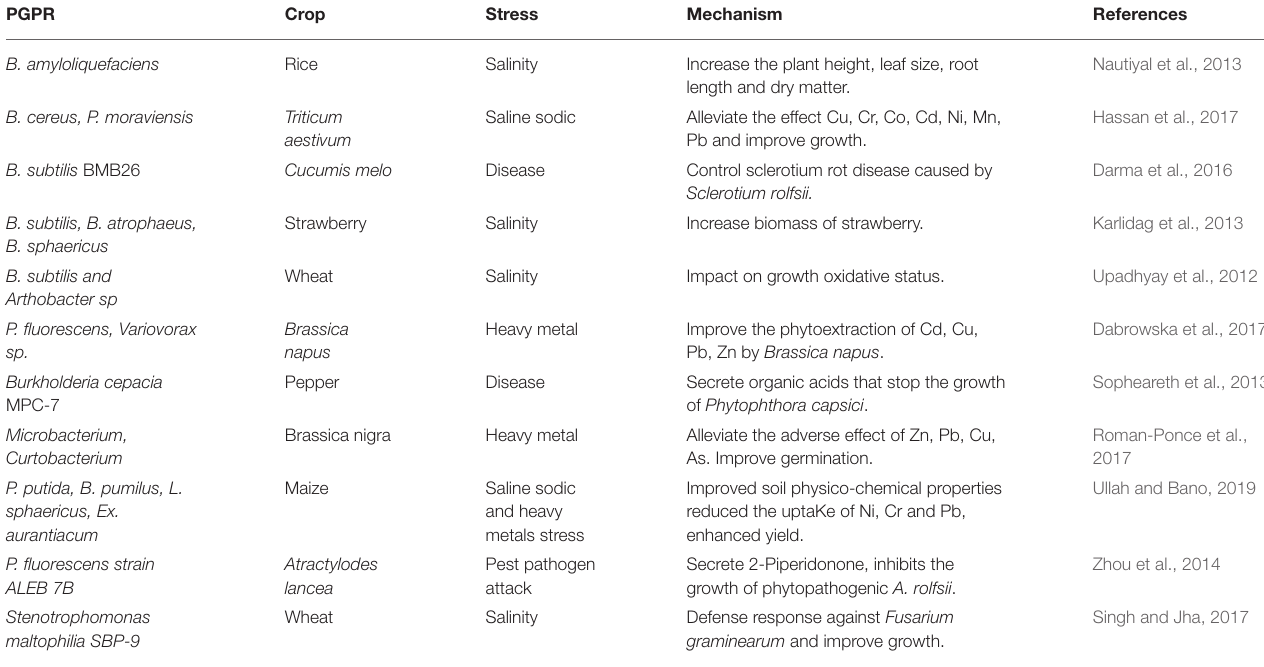
TABLE 1 | Alleviation of different stresses in crops by